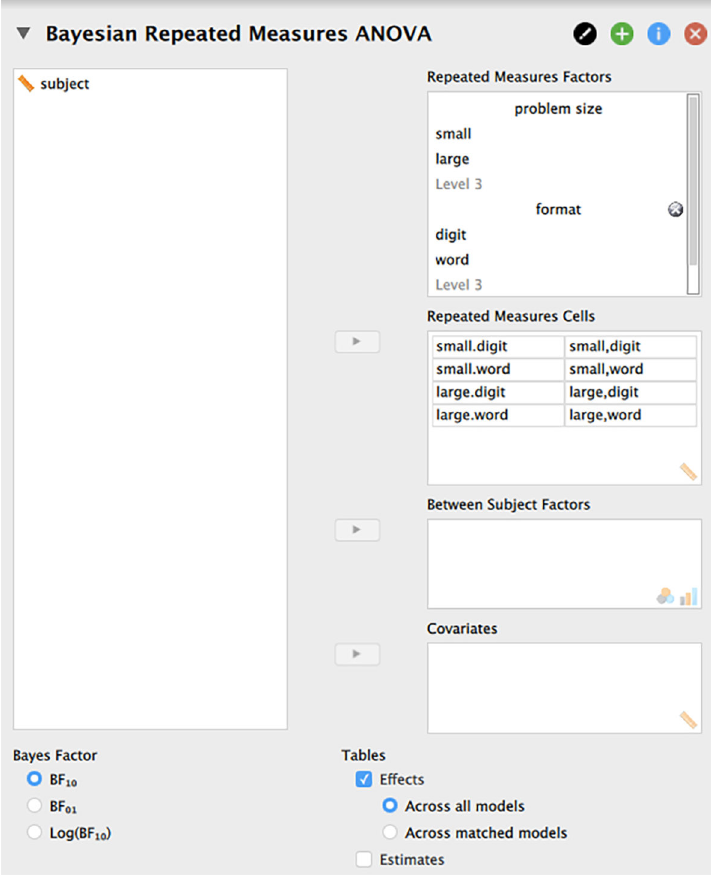
Figure 10. JASP screenshot of the Bayesian Repeated Measures ANOVA